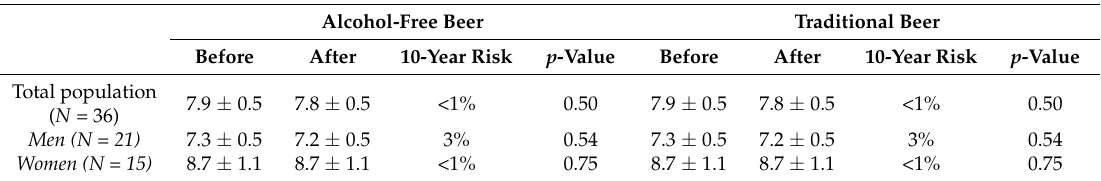
Table 8. Effect of beer consumption on the Framingham Risk Score